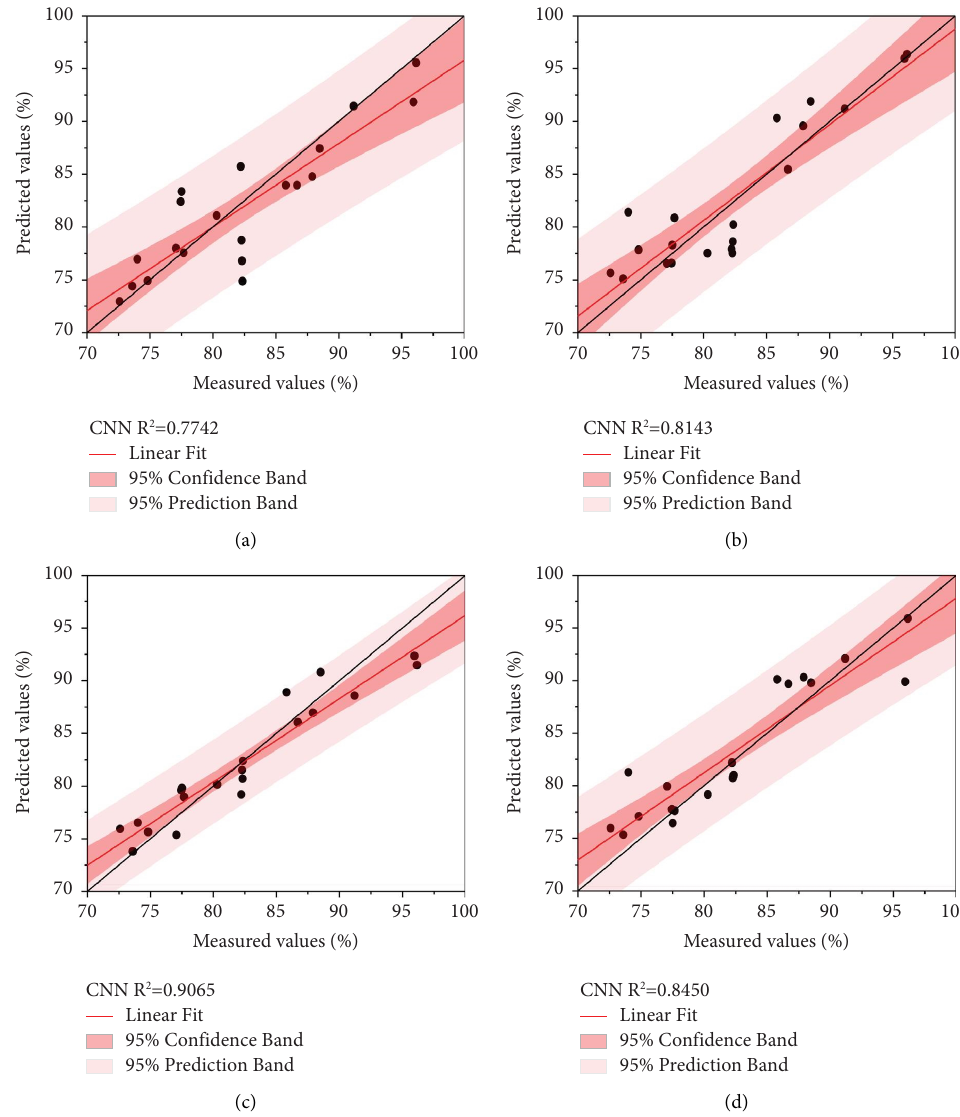
Figure 8: Prediction of the PCA-CNN model: (a) original data; (b) frst-order derivative; (c) reciprocal logarithm; and (d) MSC. Te black and red lines show the 1:1 relationship and the model trend. Te reciprocal logarithm-PCA-GRNN model falls within the largest number of points within the 95% confdence